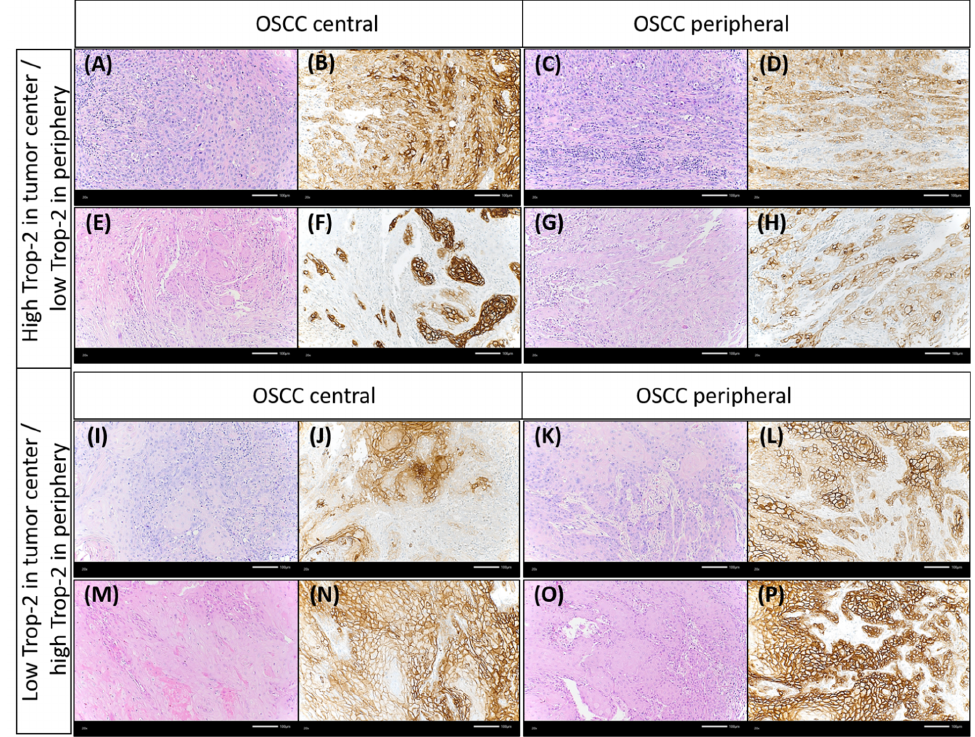
Figure 5. Discrepancy of Trop-2 expression between different tumor regions (central vs. periphery). Some OSCC cases presented with higher Trop-2 expression in the tumor center than in the periphery. Case 1: ( A , B ) representing the tumor center, ( C , D ) showing the peripheral tumor region. Case 2: ( E , F ): tumor center, ( G , H ): peripheral tumor region. Few cases showed lower Trop-2 expression in the tumor center than in the periphery. Case 3: ( I , J ) representing the tumor center, ( K , L ) showing the peripheral tumor region. Case 4: ( M , N ): tumor center, ( O , P ): peripheral tumor region [( A , C , E , G , I , K , M , O ): hematoxylin & eosin; the remainder: Trop-2 immunohistochemistry, each ×200 magnification].